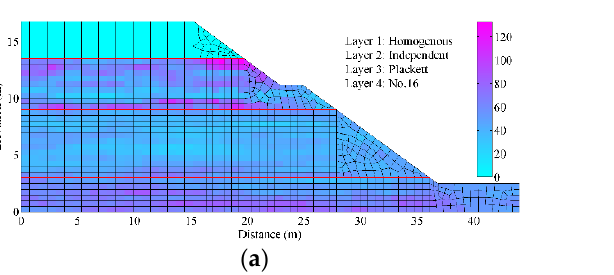
Figure 18. A typical realization of transversely anisotropic CCRF yielded by strategy 2. ( a ) Random field of c. ( b ) Random field of ϕ.